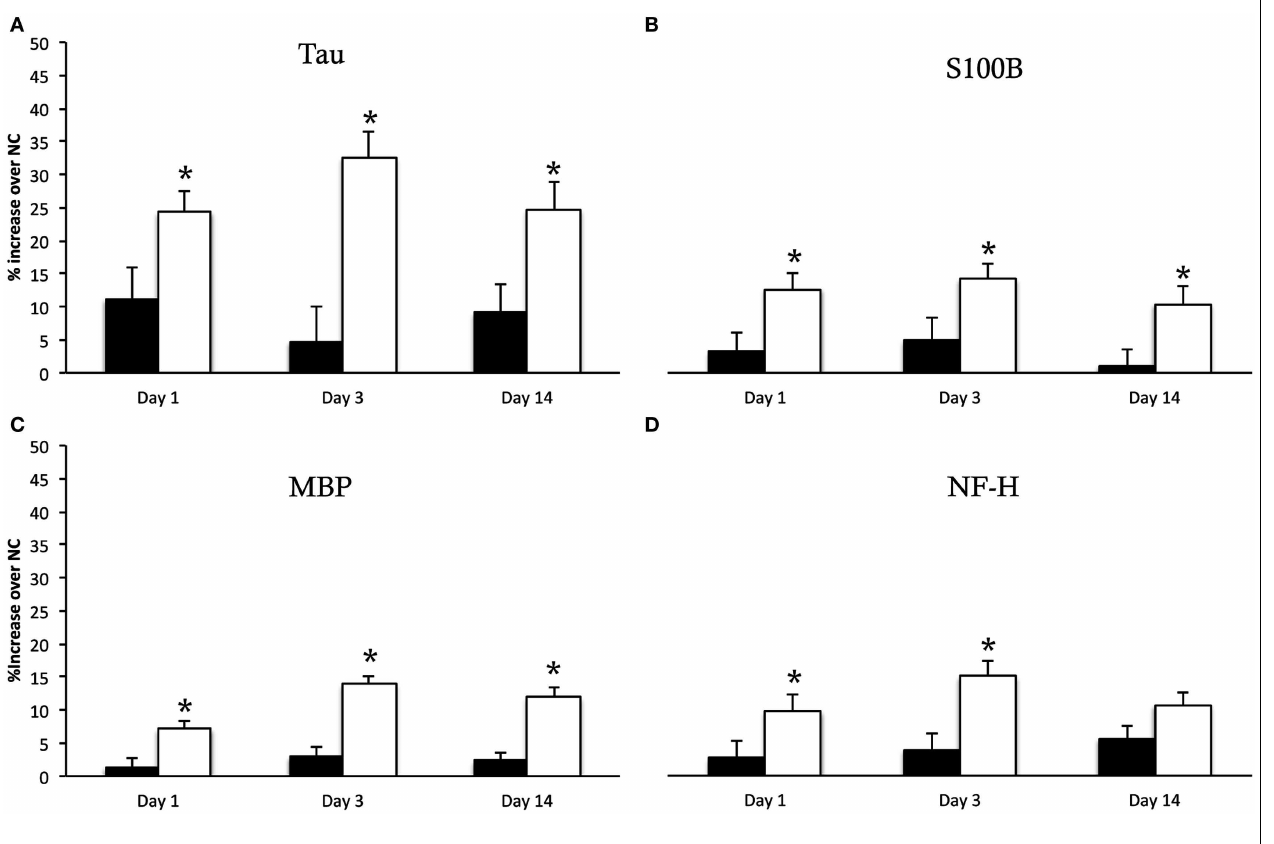
FIGURE 4 | Serum biomarkers. Y -intercept values are percentage increase of each biomarker in sham animals (black bars) and injured animals (white bars) compared to normal controls (NC), given as mean ± SD.The biomarker Tau (A) showed the most pronounced increase following injury.The